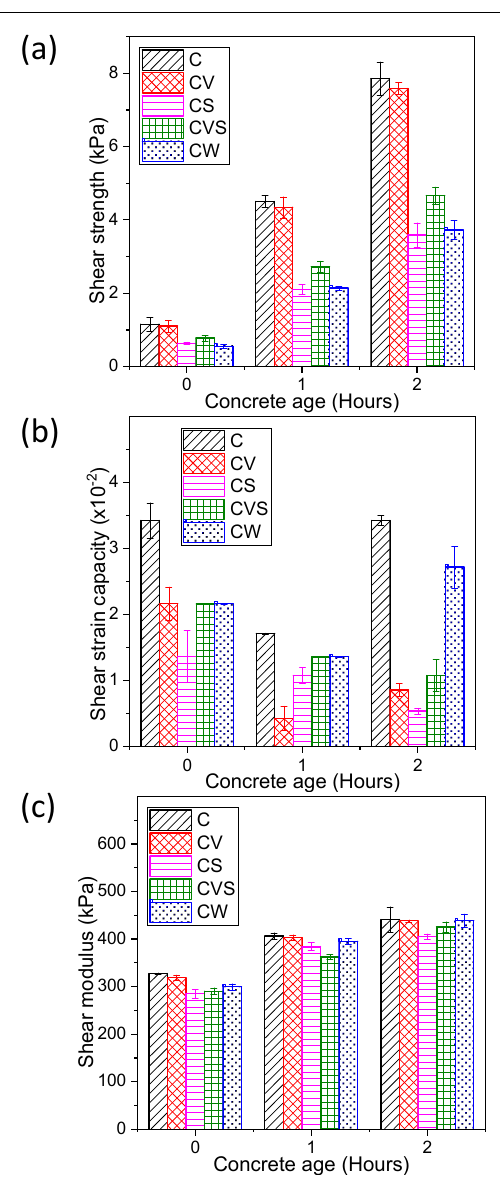
Figure 7. Rheo ‐ physical properties (a – yield stress, b – yield strain, c – modulus) of the concrete mixes measured at 0, 1 and 2 hours concrete age.